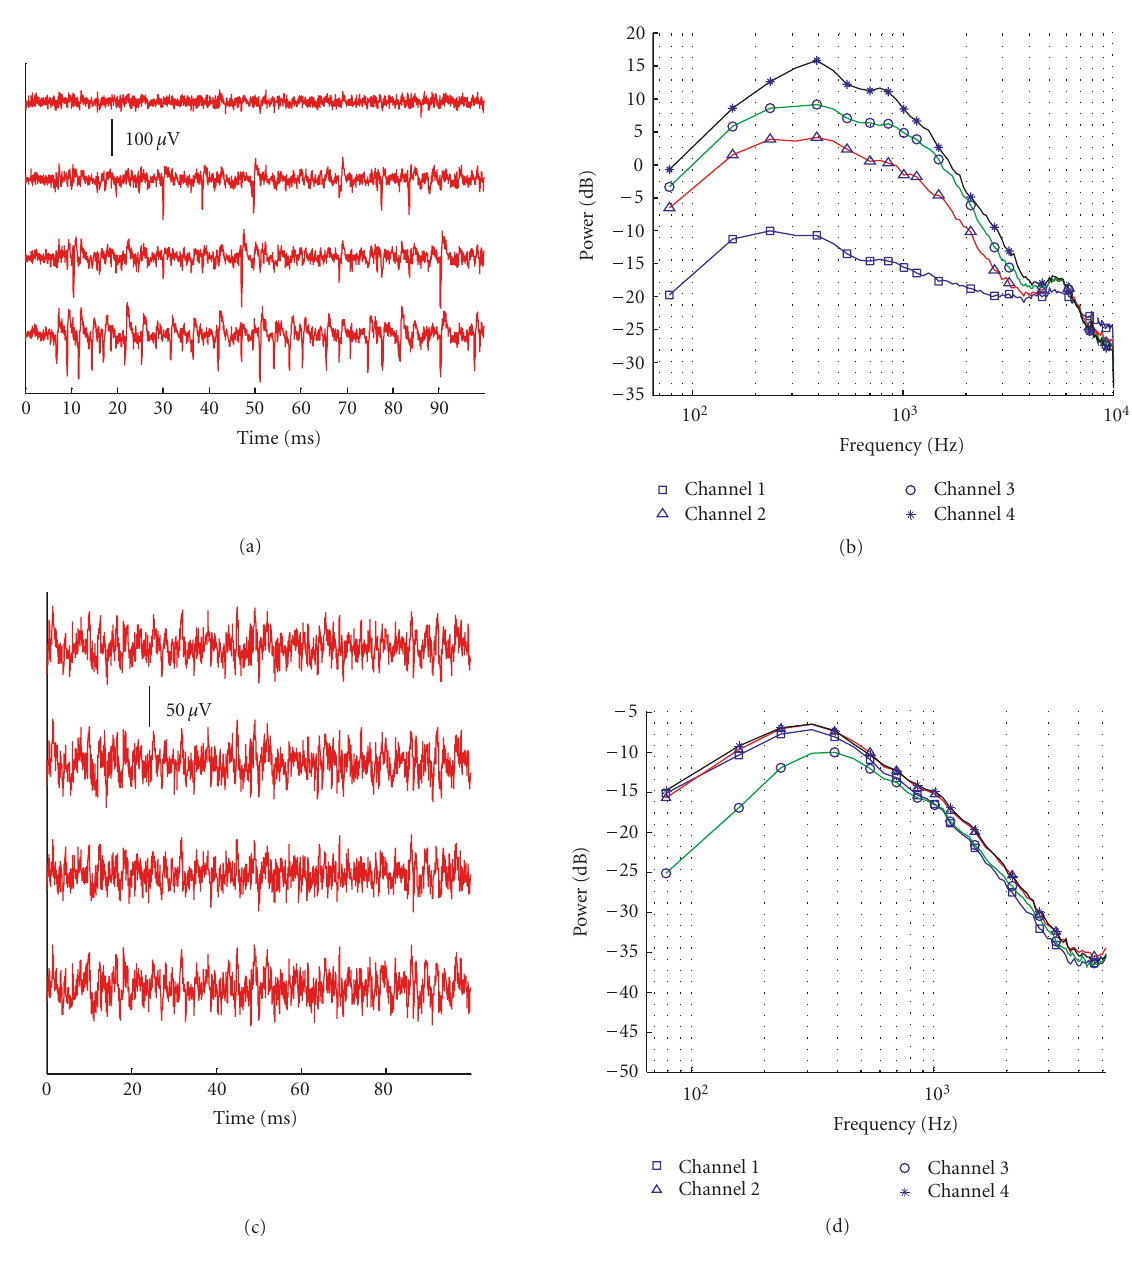
Figure 3: Characteristics of neural data measurements by a 4-electrode array. Data in (a) panel is considered high SNR signals (SNR > 4dB), while (c) panel is considered low SNR signals (SNR < 4dB). The right panels illustrate the power spectral density of both data traces and show that most of the spectral content of the noise matches that of the signal within the 10Hz–10kHz bandwidth but with reduced power indicating that neural noise constitutes most of the noise